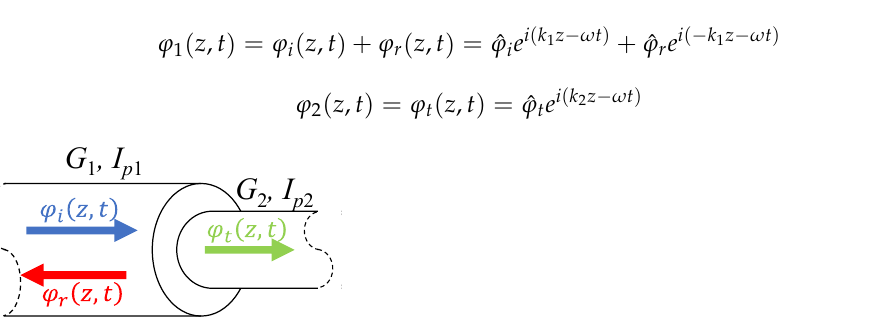
Figure 2. Torsional wave reflection and transmission from a geometric change.